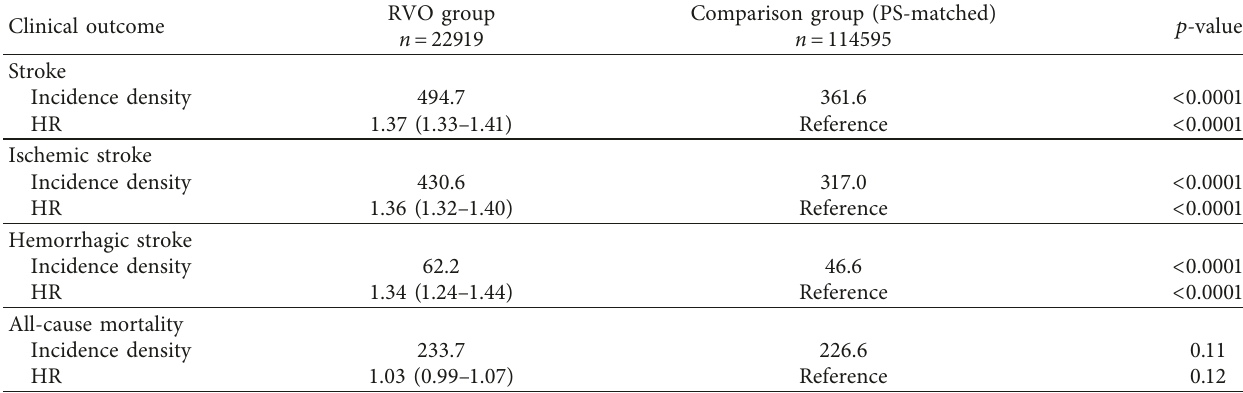
Table 2: Risk of the clinical outcomes in the RVO and comparison groups.